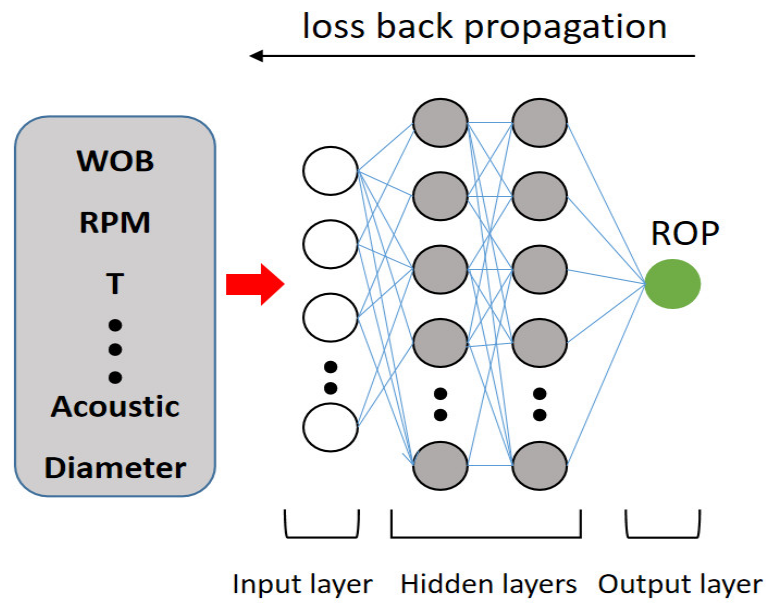
Figure 4. BP neural network algorithm.